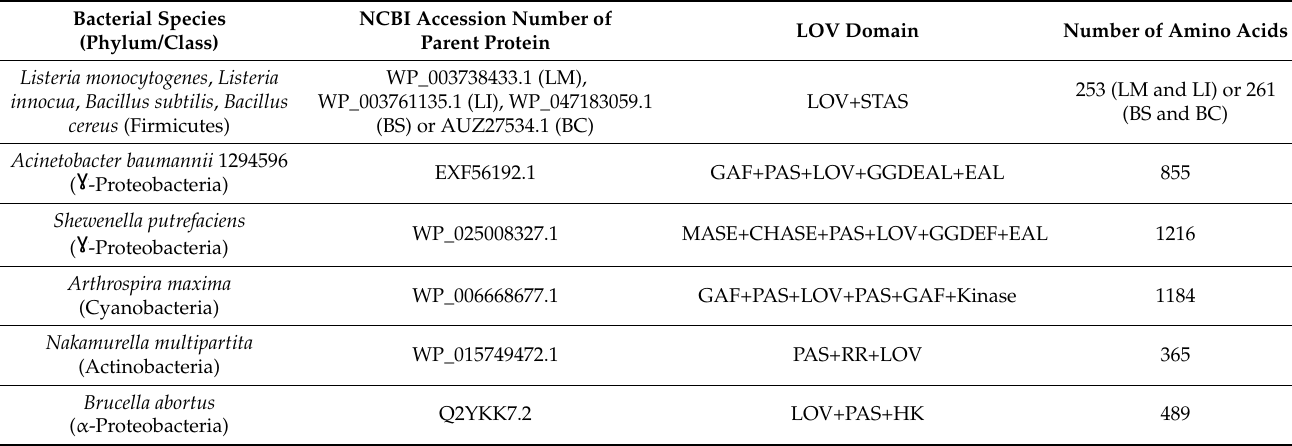
Table 2. Selected prokaryotic proteins containing different LOV domains.